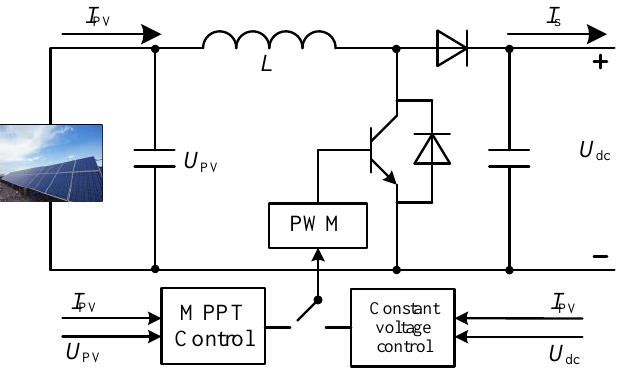
Figure 3. Structure and control scheme of PV power generation.